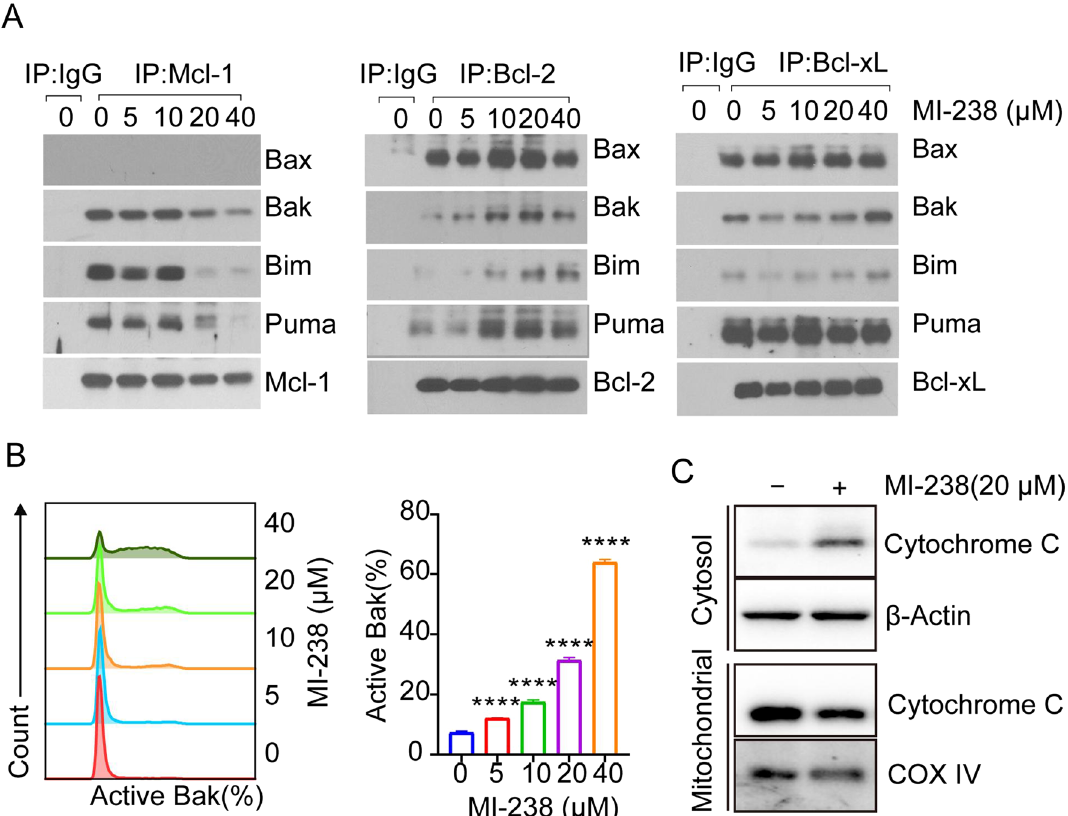
Fig. 4 MI-238 disrupts the association of Mcl-1 with BH3-only proteins. A Molm13 cells were treated with indicated concentrations with MI-238 for 24 h, followed by Immunoprecipitation (IP) assay using anti-Mcl-1, anti-Bcl2 and anti-Bcl-xL antibodies and western blot analysis with indicated BH3-only proteins. B Molm13 cells were treated with indicated concentrations of MI-238, followed by flow cytometry analysis of Bak activation using the antibody (clone: G317-2) specifically recognized activated Bak. Data are presented as mean SD from three independent replicates, ± **** P < 0.0001 by two-tailed t-test. C Molm13 cells were treated with or without 20 μM MI-238 for 24 h. Then, subcellular fractionation was subsequently performed and the cytochrome C level in mitochondria and cytosol were analyzed by western